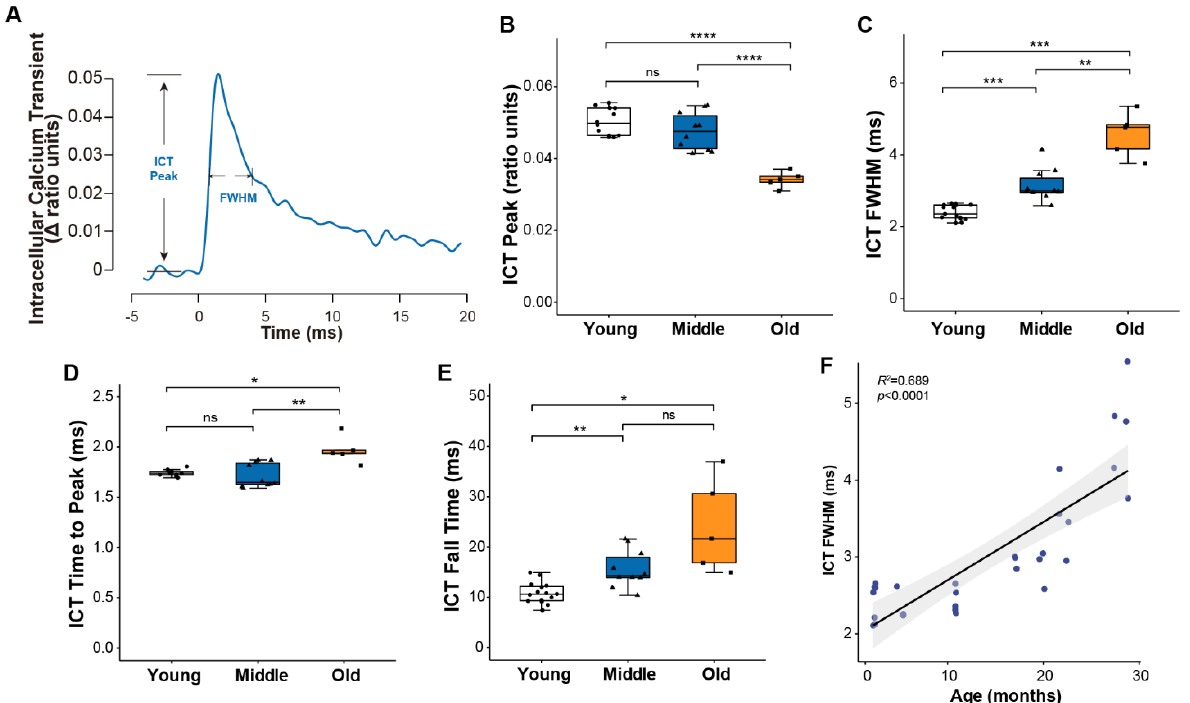
Figure 2. Muscle calcium handling properties. ( A ) Representative traces of intracellular calcium transient reported by mag-fura-2 during a single twitch contraction, with parameters used to describe calcium handling properties annotated on the graph. Data are shown for ( B ) the peak of the intracellular calcium transient (ICT peak), ( C ) time during which the ICT remains at or above its half maximum width (full width at half-maximum, ICT FWHM), ( D ) time for ICT transient increased to its peak, and ( E ) time for ICT transient to decrease from 90% to 10% of its maximum for lumbrical muscles of young (n = 10, white, circle), middle (n = 10, blue, triangle) and old (n = 5, orange, square) aged wild type mice. Additionally, shown is ( F ) the correlation between age and ICT FWHM analyzed by Pearson correlation (R 2 = 0.689, p < 0.0001). Data in B - E are presented as individual data points with box plots and error bars indicating the minimum, first quartile, median, third quartile, and maximum number of the dataset. Data were analyzed by one-way ANOVA, * p < 0.05, ** p < 0.01, *** p < 0.001, **** p < 0.0001.